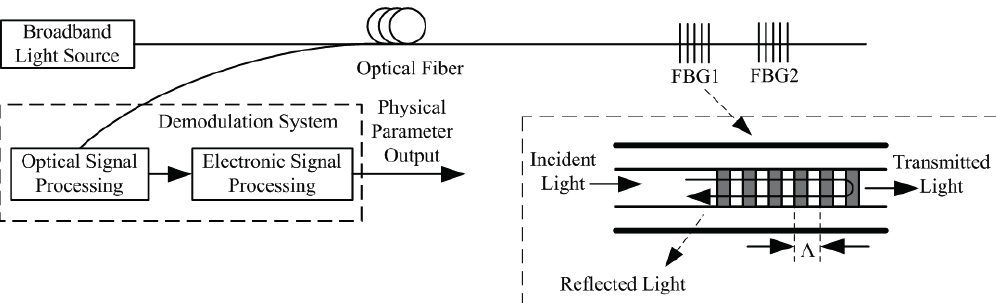
Figure 1. Schematic diagram of the fiber Bragg grating (FBG) sensing